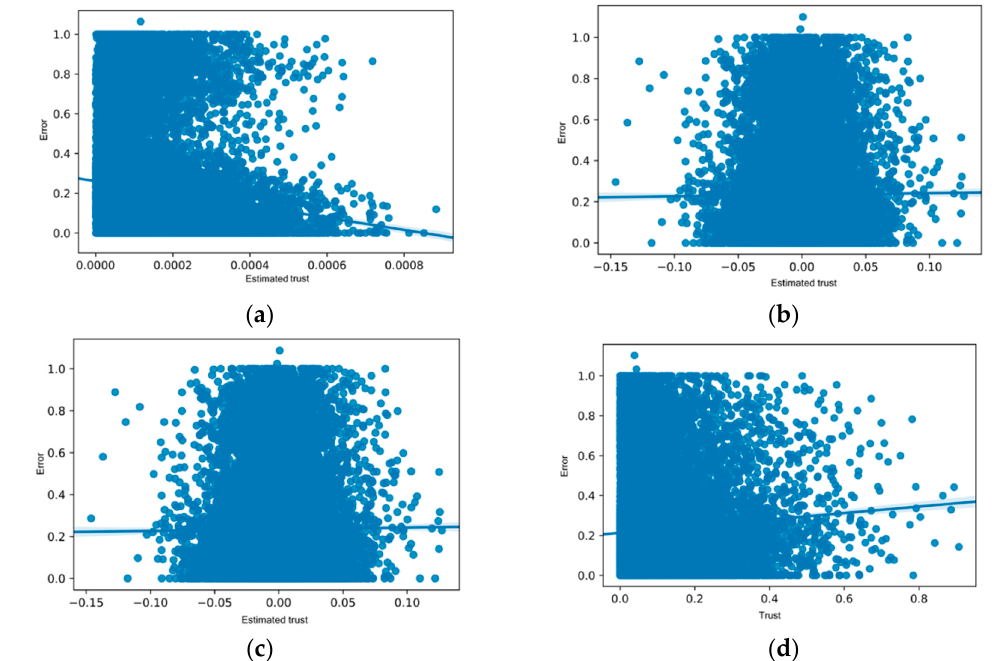
Figure 3. Errors in predictions versus trust (or estimated trust) for the ML-100k data set, corresponding to different methods. ( a ) Mean estimated trust against signed error in rating prediction using M-Trust. ( b ) Estimated trust against signed error in rating prediction using S-Trust. ( c ) Estimated trust against signed error in rating prediction using W-Trust. ( d ) Initial trust against signed prediction error for I-Trust.